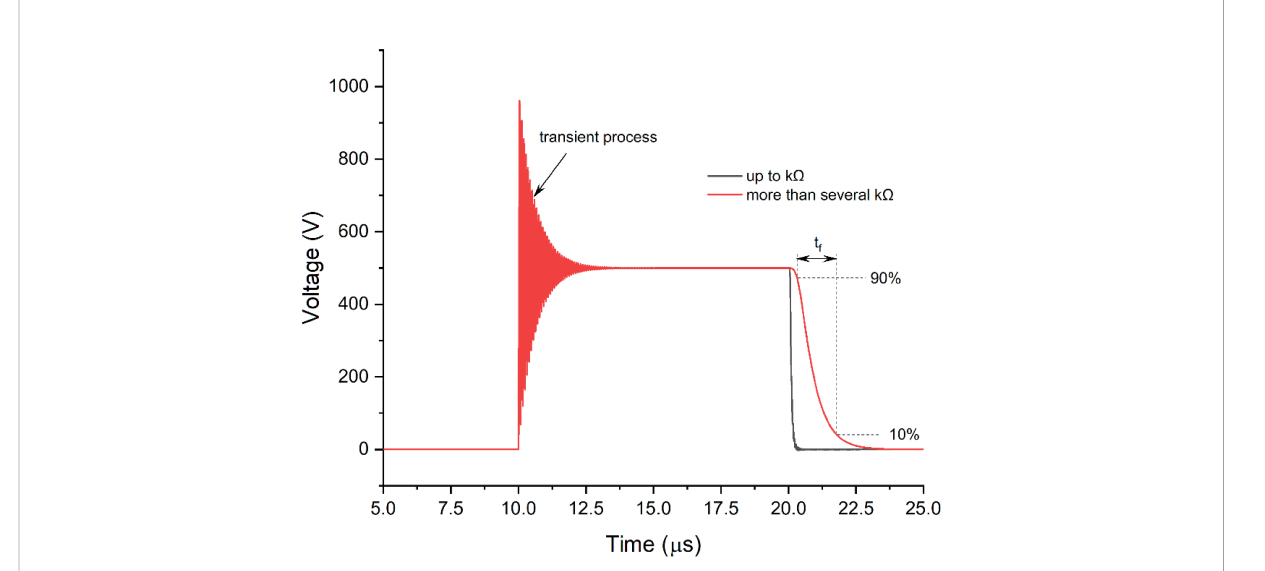
FIGURE 3 An example of the typical in fl uence of the load impedance on pulse shape.